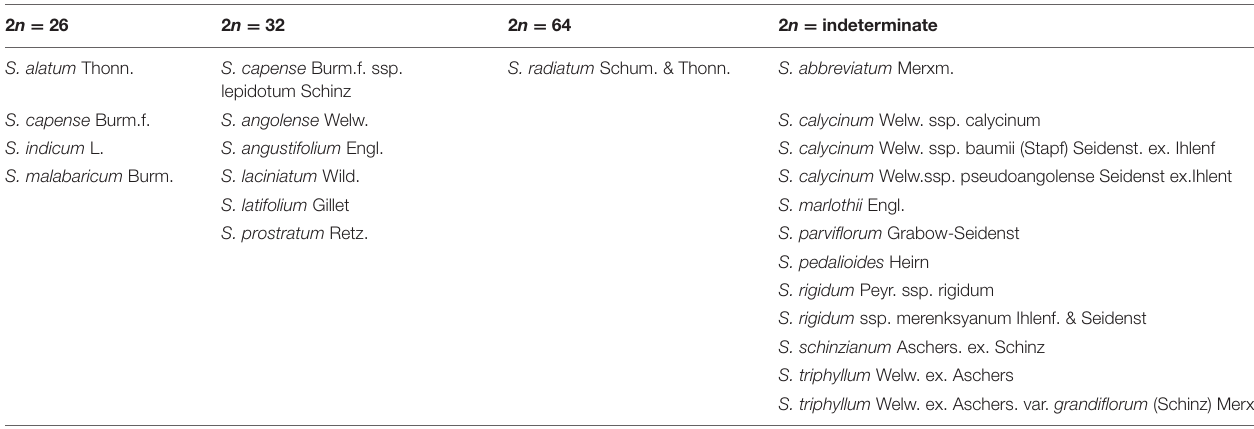
TABLE 1 | Revised list of Sesamum species and their chromosomes number (2 n ). 2 n = 26 2 n = 32 2 n = 64